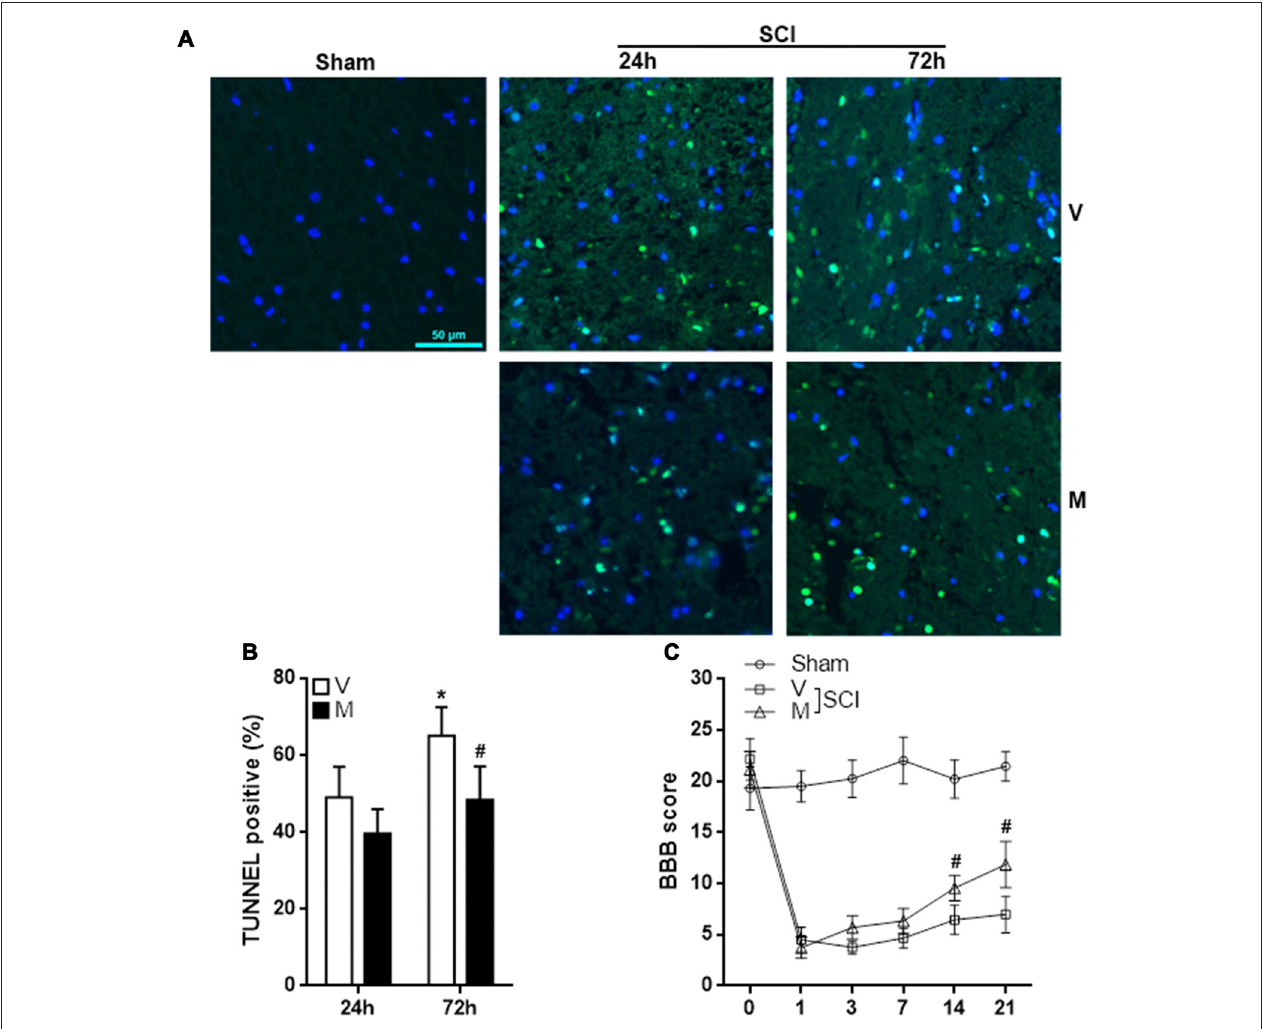
FIGURE 7 | Methylene blue inhibits cell apoptosis in injured spinal cords and improves function recovery. (A,B) Terminal deoxynucleotidyl transferase dutp nick end labeling (TUNEL) staining indicating cell apoptosis in spinal cords 24 h and 72 h post SCI. Fluorescent images are shown in (A) . Statistics of the proportion of apoptotic cells were shown in (B) . N = 4 per group. (C) BBB score. N = 10 per group. V: vehicle; M: methylene blue treatment. ∗ p < 0.05 in comparison with “24 h” vehicle group. # p < 0.05 in comparison with the corresponding vehicle group of each time